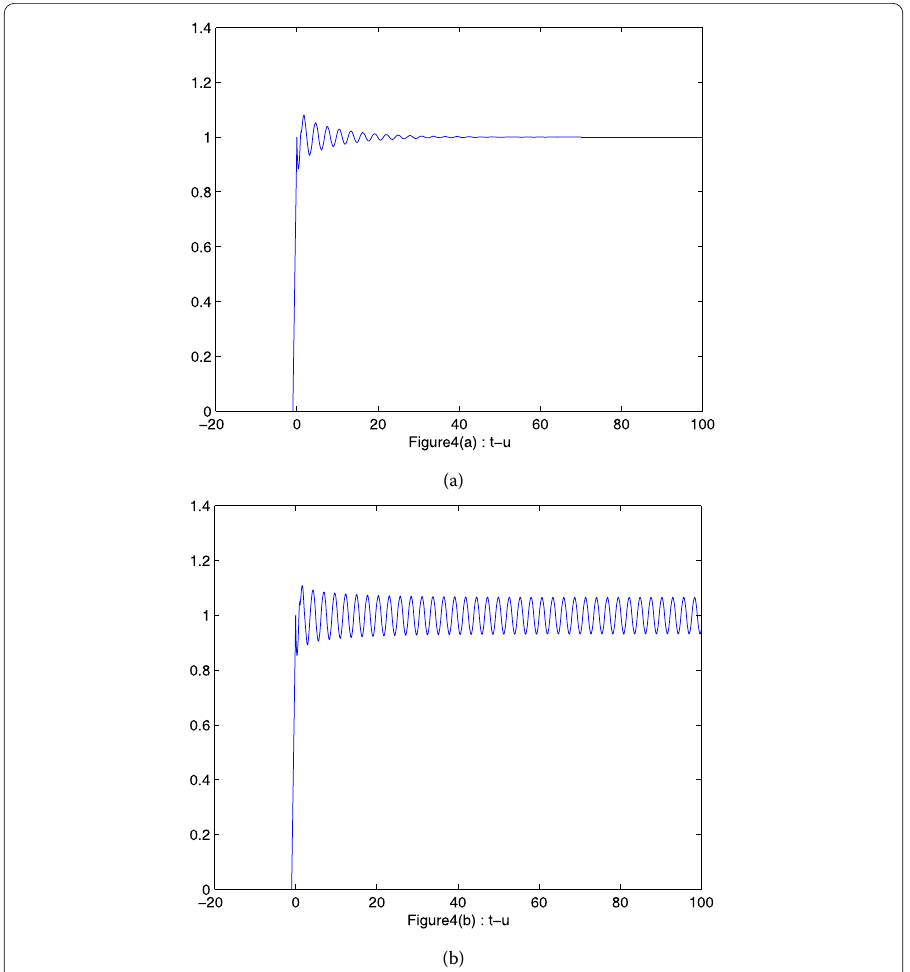
Figure 4 The numerical solution of Eq. (2.11) with PD control Euler method corresponding to k p = –0.2, k d = –0.2 when ( a ) τ = 7, ( b ) τ =